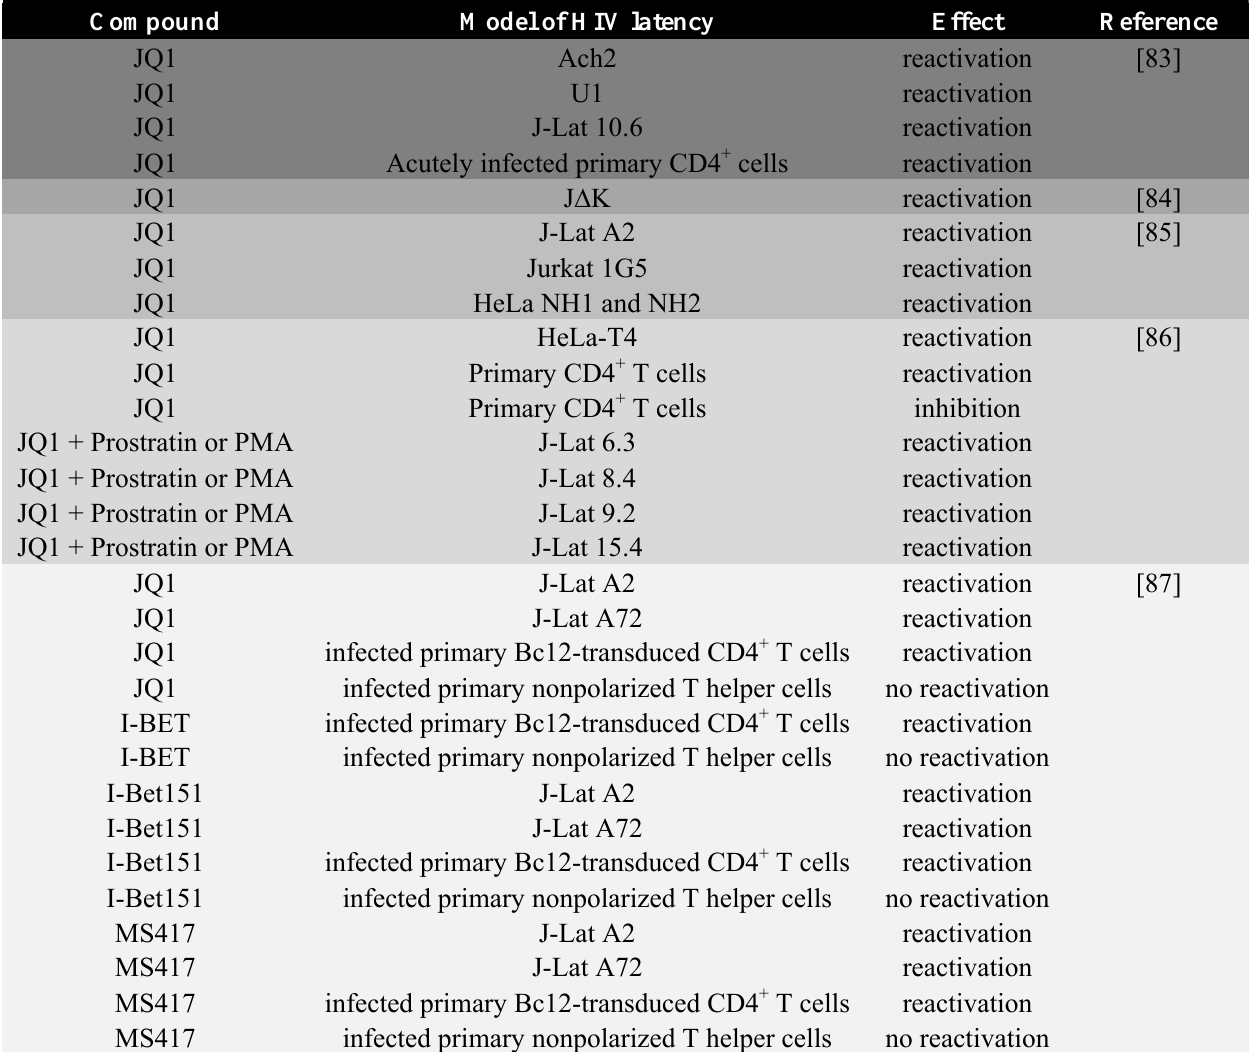
Table 1. Selected reported bromodomain inhibitors tested in models of HIV